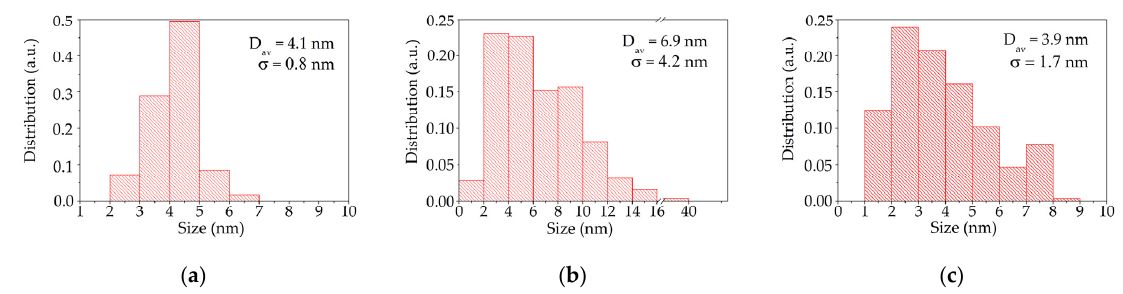
Figure 2 . Historgrams of particle size distribution: ( a ) Pd/Al 2 O 3 ; ( b ) PdBi/Al 2 O 3 ; ( c ) Pd → Bi/Al 2 O 3 .